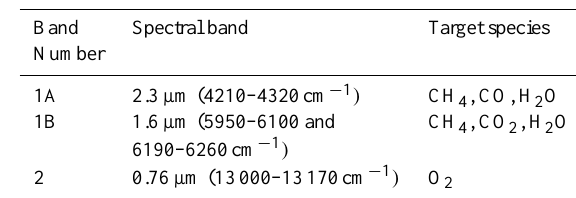
Table 1. The GeoFTS spectral bands and the target